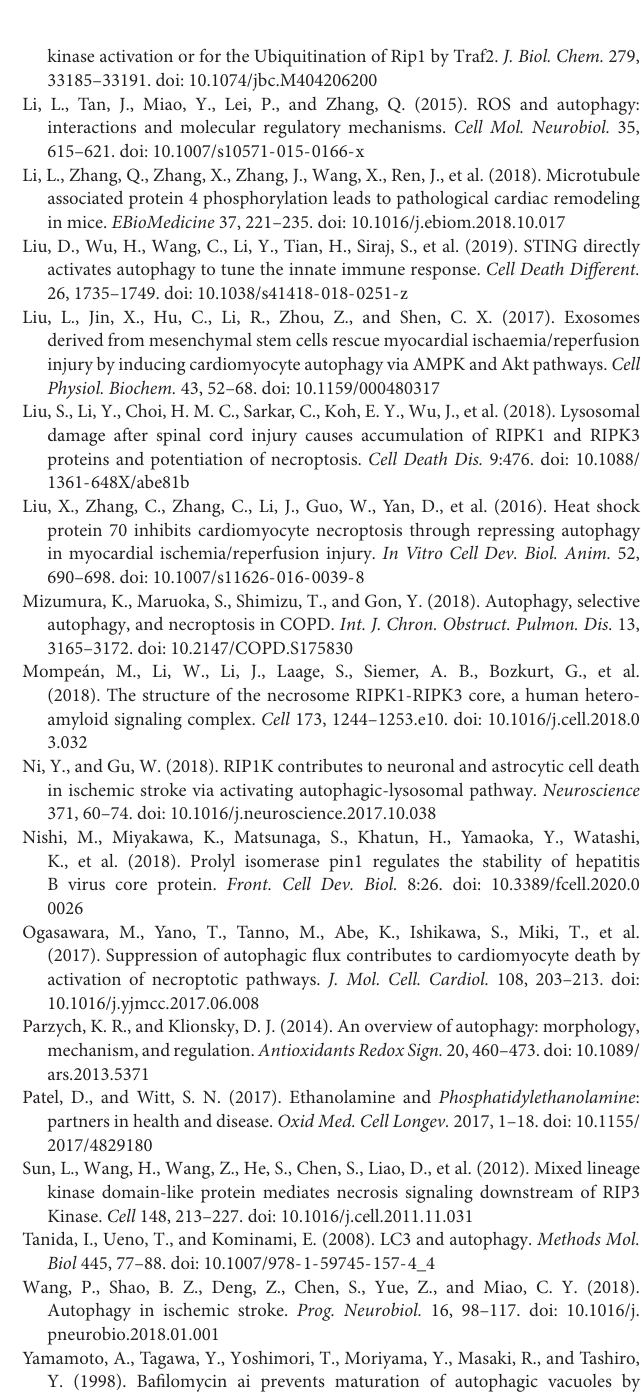
analysis of p-MLKL in corresponding groups in panel (A) Scale bar, 10 µ m, Mean ± SEM, n = 3. ∗∗∗ p < 0.001 versus the Ctrl + CMV group, ### p < 0.001 versus the Ctrl + ATG5-OE group. (G–I) Western blotting and statistical analysis of ATG5, LC3, RIPK1, RIPK3, p-RIPK3, MLKL, and p-MLKL from Hypoxia + CMV, Hypoxia + ATG5-KD, and Hypoxia + ATG5-KD + LC3-OE groups. Mean ± SEM, n = 3. Ns means no statistical difference, ∗∗ p < 0.01, ∗∗∗ p < 0.001 versus the Hypoxia + CMV group, ## p < 0.01 and ### p < 0.001 versus the Hypoxia + ATG5-KD group. (J) LDH leakage analysis was performed to determine cell death